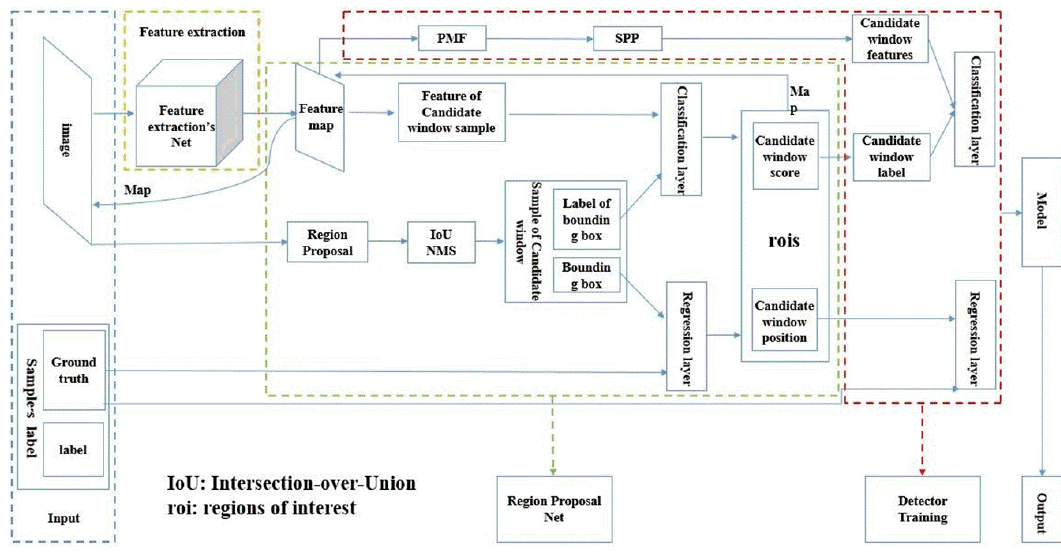
Figure 1. Detection flow chart of Faster-RCNN (Regions with CNN features, RCNN). The inputs are images and labels. The output is a detection model containing a large number of neuron parameters. The middle section will be explained later in the article.